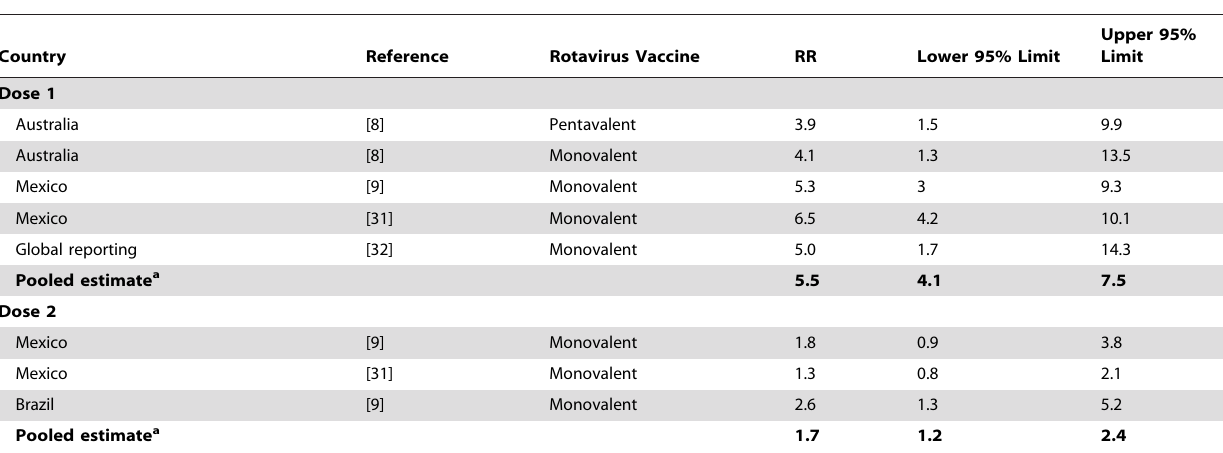
Table 3. Pooled estimates of risk after doses 1 and 2 of rotavirus